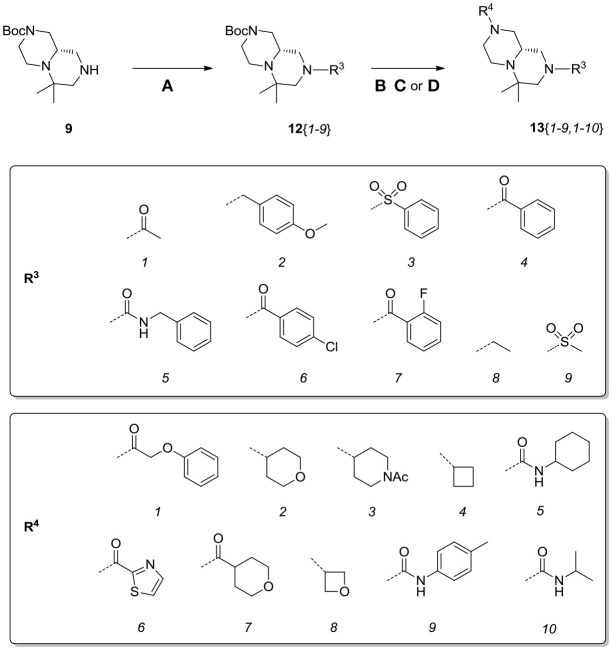
Synthesis of library 13. Reagents and conditions: (A) acyl chloride (or sulfonyl chloride or isocyanate), Et3N, DCM, rt; (B) acyl chloride or sulfonyl chloride, Et3N, DCM or (C) isocyanate, DCM or (D) aldehyde/ketone, borane-Me2S complex, DCM.